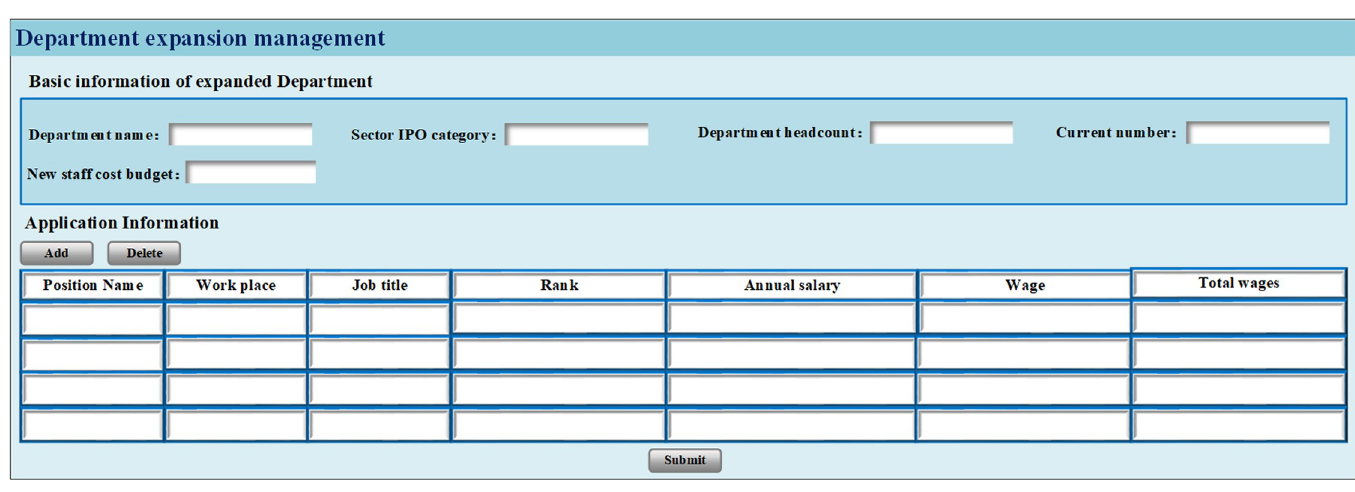
Fig 13. Realization effect of the interface of the organizational management.